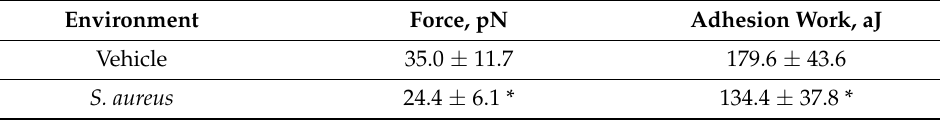
Figure 3. The force ( A ) and work ( B ) of adhesion between the receptors of neutrophils of different donors and ligands of EA.hy926 cell line endotheliocytes show suppression of interaction under non-opsonized S. aureus 2879 M. Mean ± SD are shown. A–F show different neutrophil donors. There were at least 5 experiments containing no less than 4 technical replicates for each donor both for control and experiment (minimum of 20 FS curves for each experiment were analyzed). * Significant differences between control and experiment ( p < 0.05). Table 1. The total values of the force and work of adhesion between endothelial cells and neutrophilic granulocytes under the influence of non-opsonized S. aureus 2879 M. The table shows the data of 21 force curves for each control and experiment for a series of 5 experiments (cells from different donors were